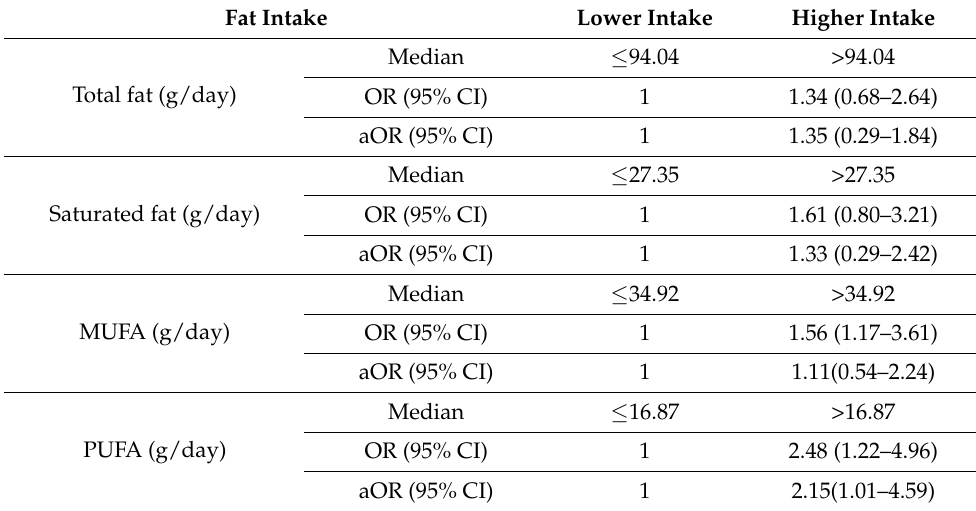
Table 4. Crude and adjusted ORs for the risk of KRAS mutations in colorectal tumors, according to the intake of fat variables (low consumers versus high consumers based upon median intake) (N =